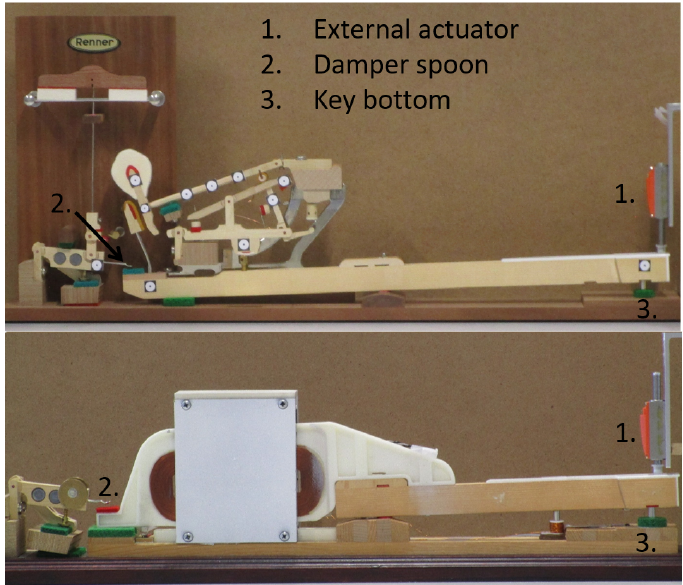
Figure 23. Piano haptic key: measurements of the force felt by the pianist F haptic through an external linear actuator for the Renner ® demonstrator ( up ) and the haptic prototype ( bottom )